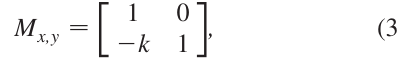
¼ (cid:1) 0 : 1 , y ¼ 1 : 2 , and p ¼ (cid:1) 0 : 02 x y